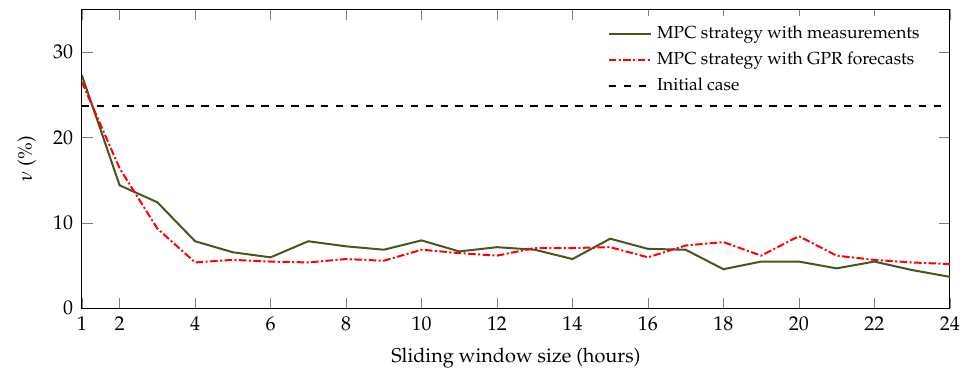
Figure 8. Percentage of time steps where an overshooting is observed, with respect to the sliding window size used by the MPC scheme.